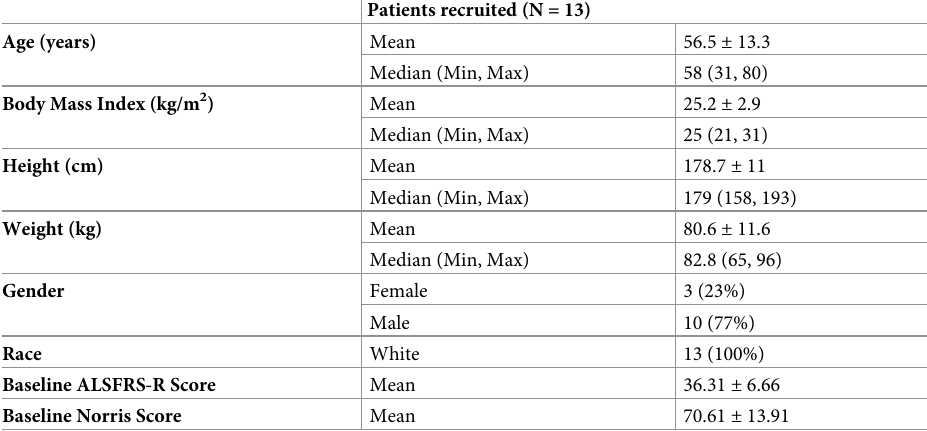
Table 3. Baseline patient demographics and clinical